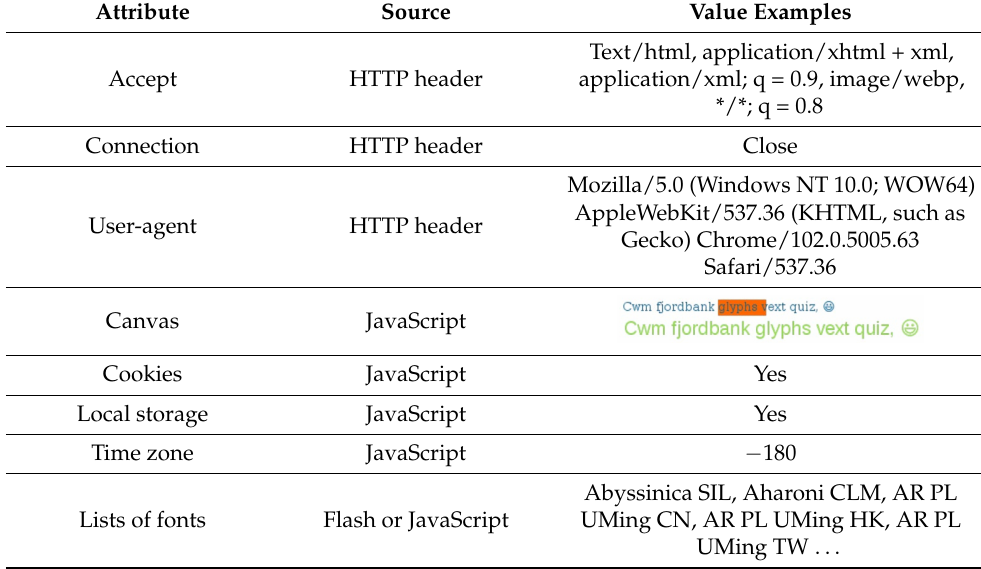
Table 1. Example of browser fingerprint.